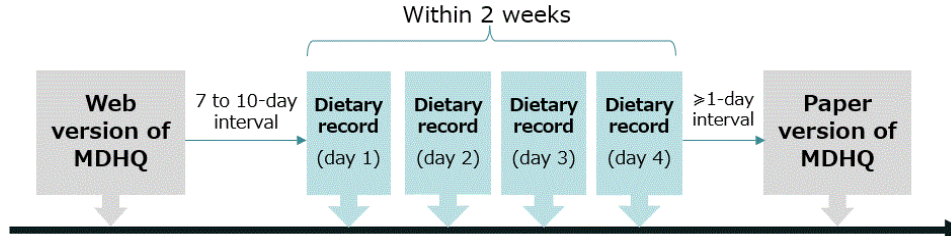
Figure 1. Study schedule. MDHQ, Meal-based Diet History Questionnaire; DR, dietary record.